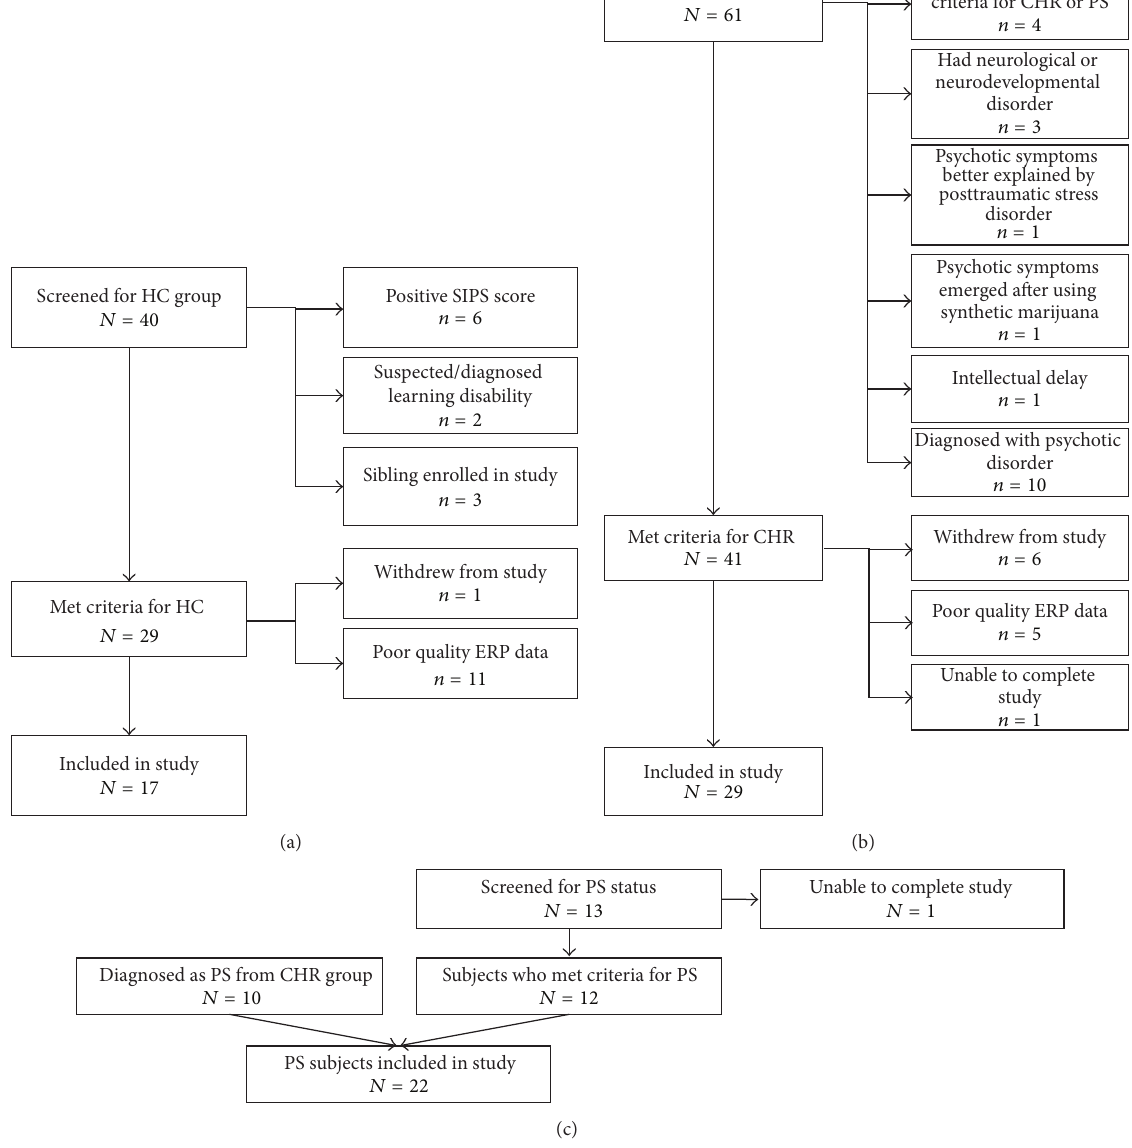
Figure 1: Flow charts depicting participants screened, reasons for exclusion, and number of participants retained for each clinical group. (a): healthy controls (HCs); (b): clinical high risk (CHR); (c): psychosis